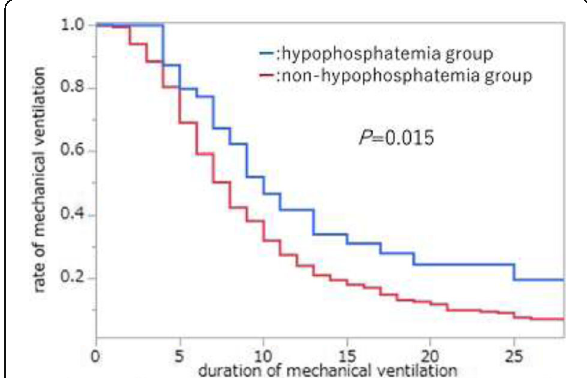
Fig. 1 (abstract 0287). Kaplan-Meier curves of time to liberation from